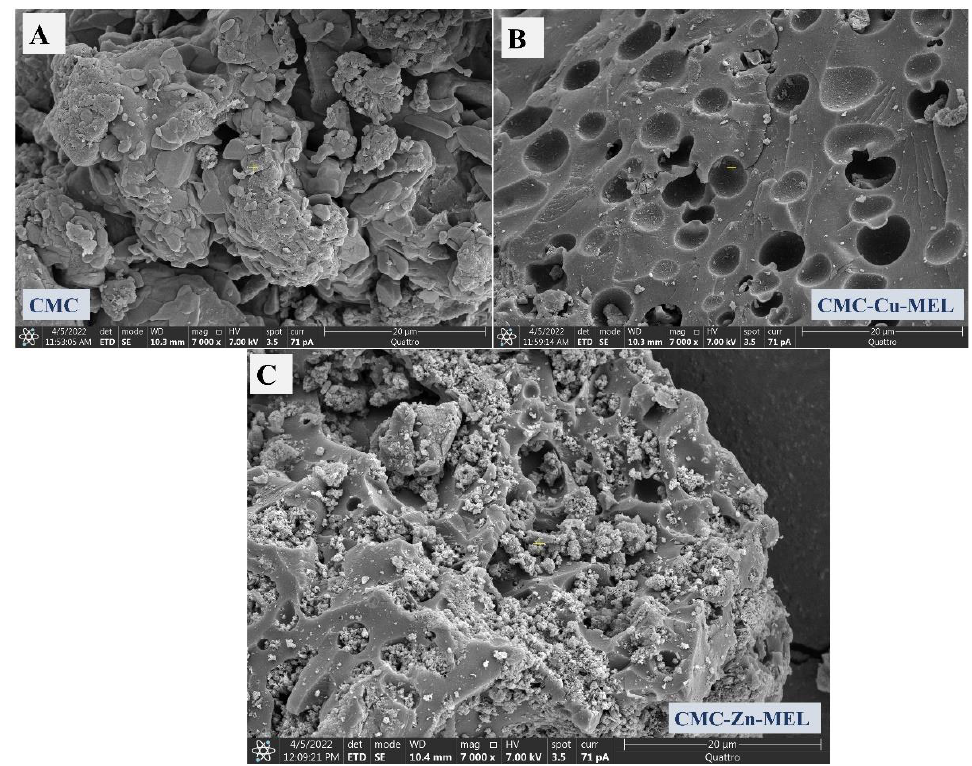
Figure 1. ( A ) SEM image of CMC, ( B ) SEM image of CMC-Cu-MEL, ( C ) SEM image of